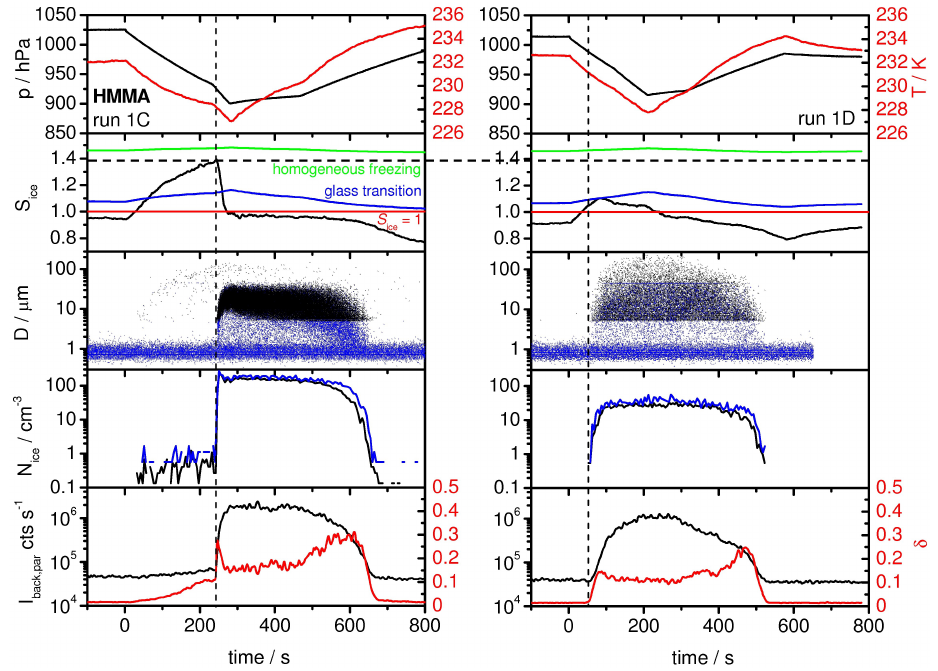
Fig. 5. Time series of various AIDA records during expansion runs 1C and 1D with HMMA. The individual panels contain the same measurements as in the right panel of Fig. 4. To facilitate the comparison between the two expansion cycles, all y-axes of adjacent panels are identically scaled. The horizontal dashed line in the second row panels denotes the homogeneous freezing limit observed in run 1C.